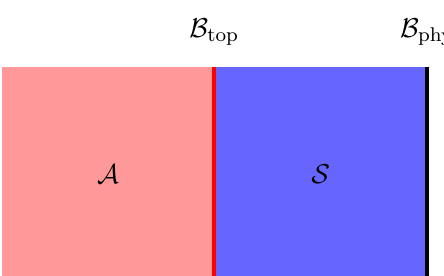
Figure 1 . The blue slab (”sandwich”) is the SymTFT S , with boundary conditions on the right ( B ) which are non-topological and to the left, which are topological B phy interface separating the symmetry theory from the anomaly theory A . The picture introduced earlier of T being defined as a theory relative to A is obtained by collapsing the blue sandwich. The anomaly theory describes anomalies for a particular choice of global structure of the